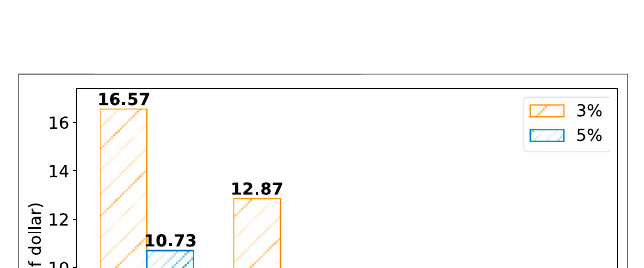
FIGURE 20 | Hurricane damage cost retro fi t is carried out in two phases